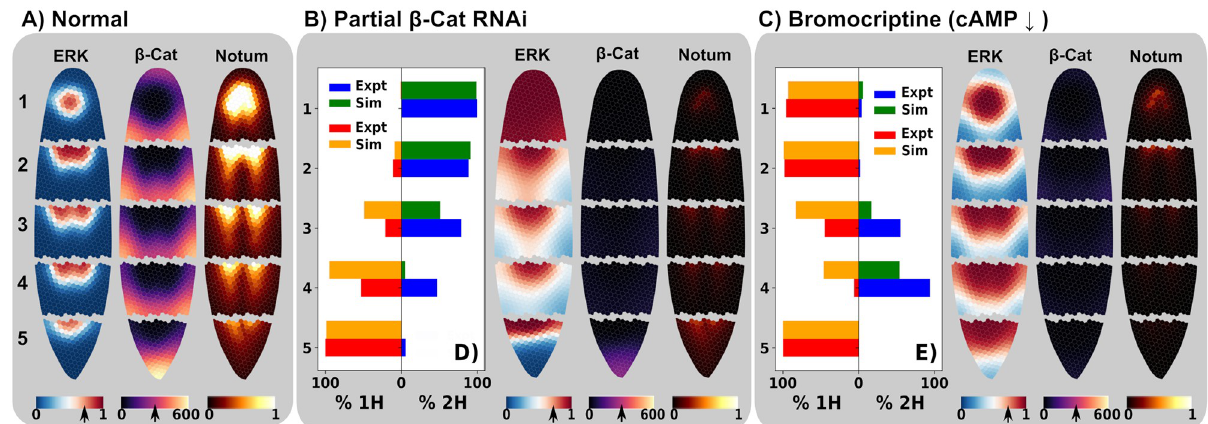
Fig 4. Model predictions and experimental regenerative outcomes show matching trends for different fragments along the anterior-posterior axis under different cases. For normal wild-type regeneration, the model predicts polarized gradients of ERK, β -Cat and Notum for each of the 5 cut fragments (A), which are predicted and found to regenerate as 100% 1H in each of the 5 cut fragments (0% 2H heteromorphoses). Partial (i.e. incompletely blocked) RNAi of β -Cat is predicted to show more morphogen gradient polarity disruption, and therefore more 2H regenerates, in fragments progressively closer to the head (B), a prediction that parallels experimental observations (D). In contrast, model perturbations inhibiting β - Cat stability (e.g. via decreased cAMP with bromocriptine treatment) are predicted to show more morphogen polarity disruption (C), and therefore, a higher frequency of 2H regenerates, in fragments cut closer to the tail (E). These modeling prediction trends are corroborated by experiment (D, E). Note that experimentally, the tail piece was only cut on one side and can consequently only regenerate as a 1H, as it only has one